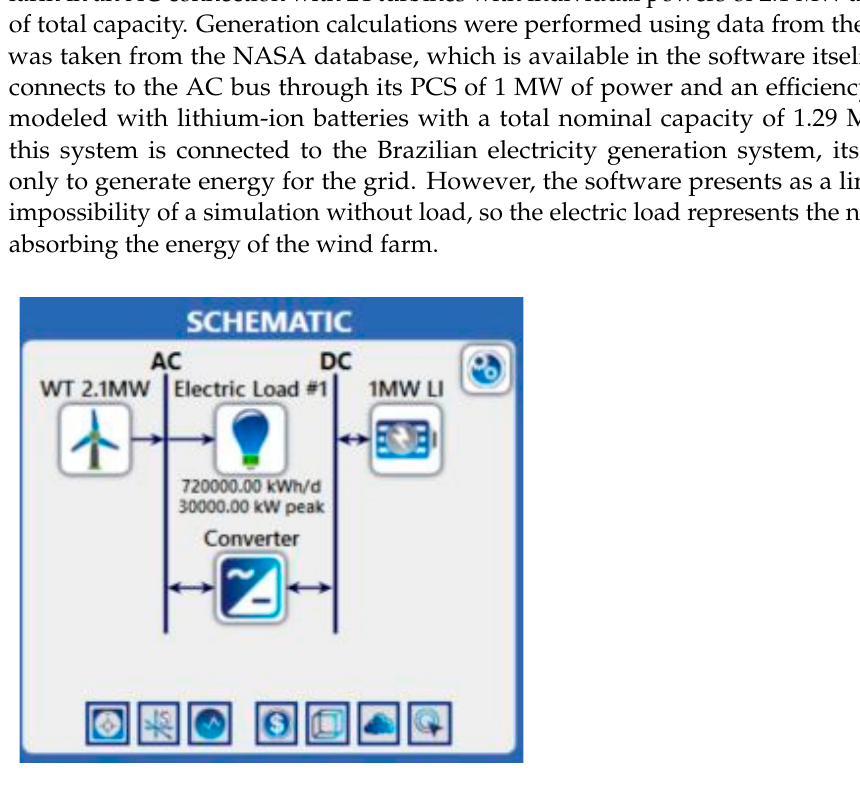
Figure 9. Result of simulation performed in Homer Pro.